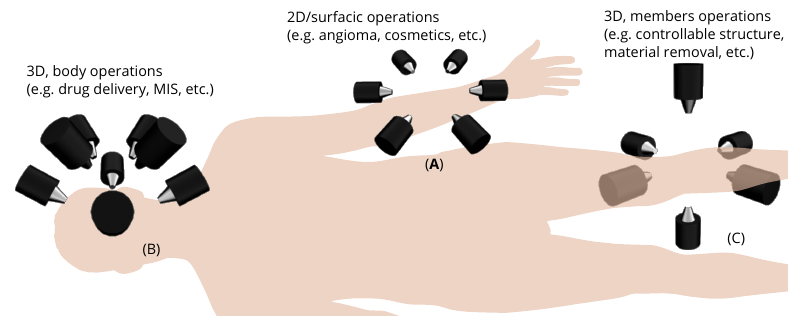
Figure 1. The concept of EMA system applying for various biomedical